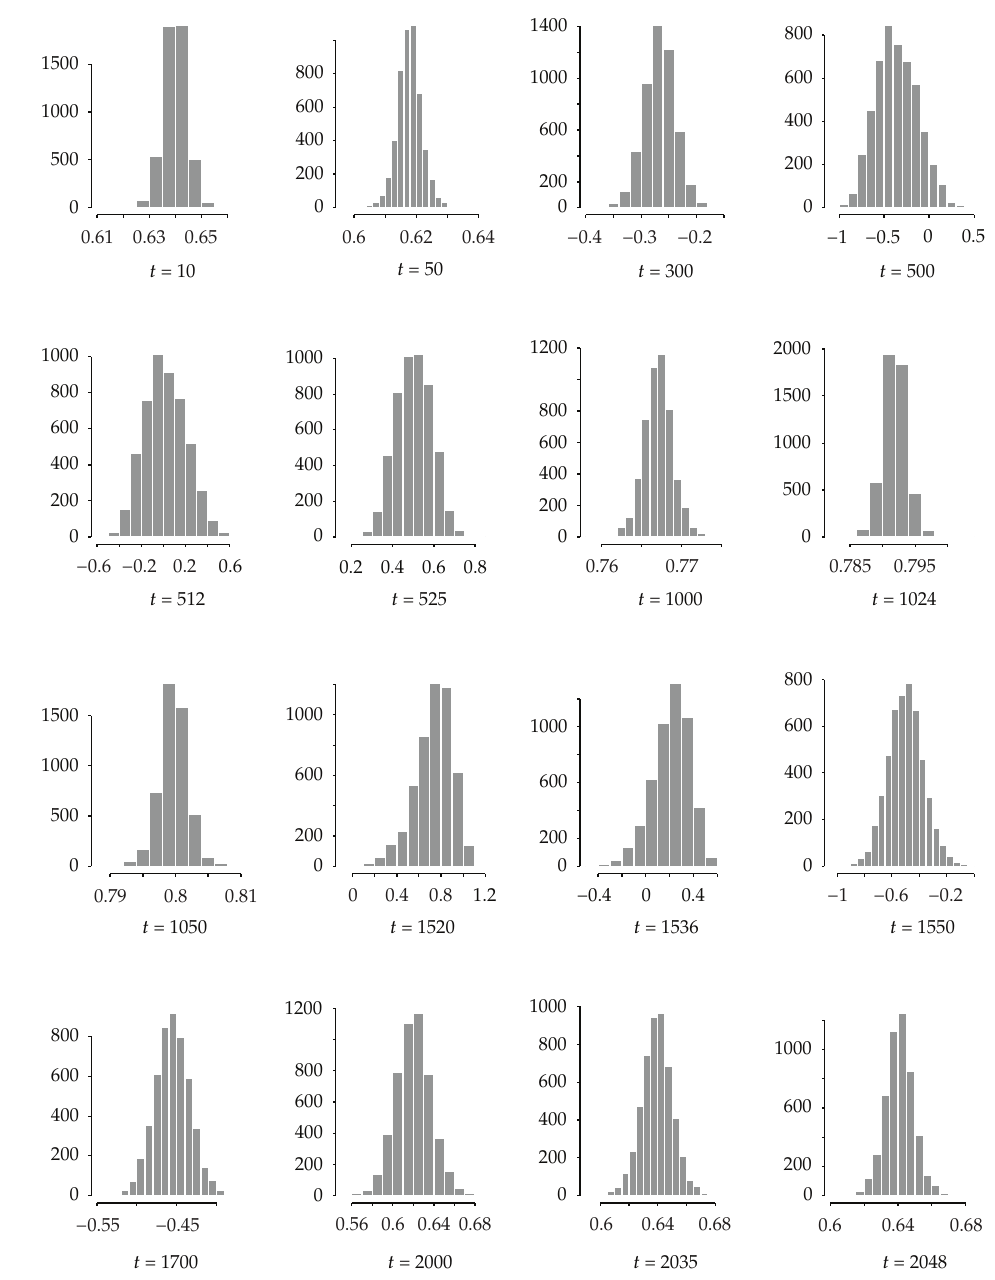
Figure 19: Example 5.2: Histograms of linear estimate of δ 1 at some points of (cid:7) 0, 1 (cid:8)